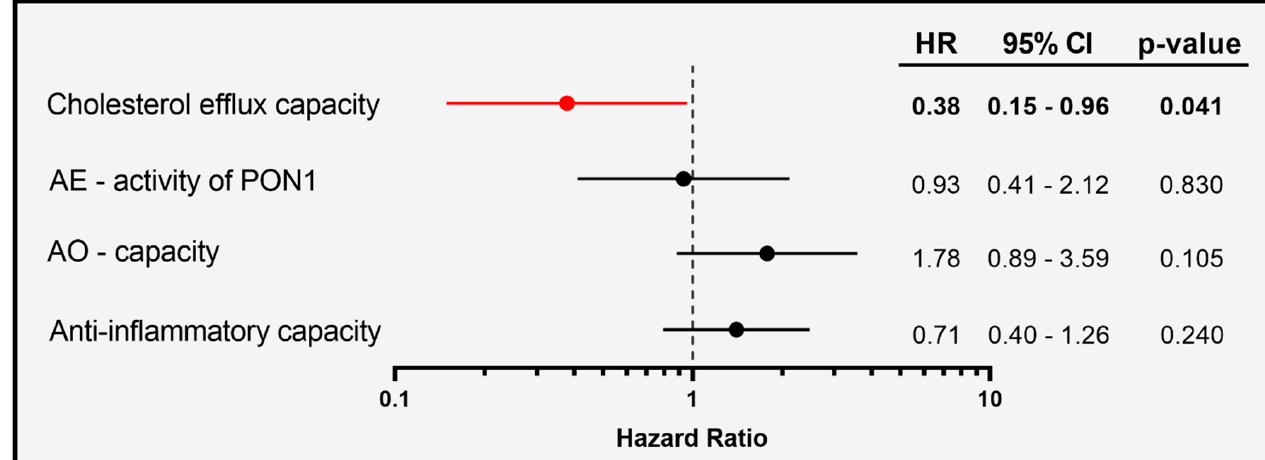
Figure 5. Survival hazard ratios (HRs) per 1 SD increase and 95% confidence intervals (CI) derived from Cox regression analyses. Model was adjusted for age, gender, and HDL-C levels.